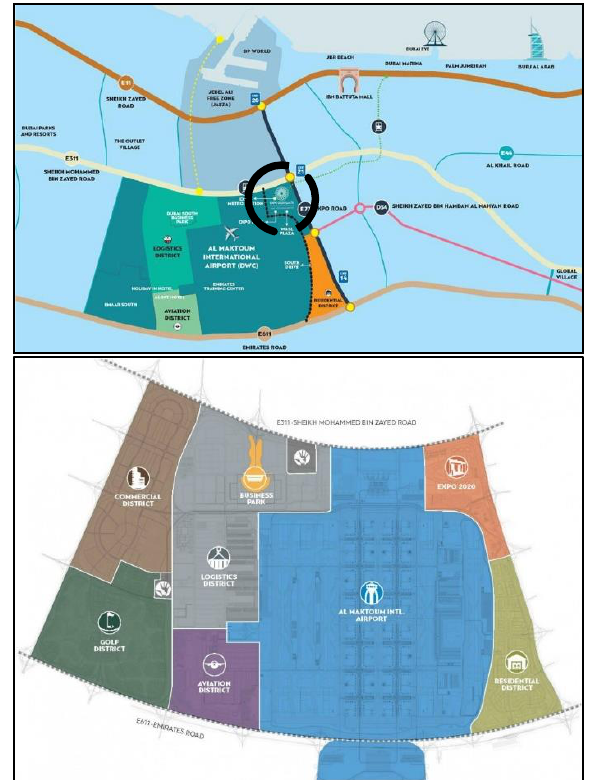
Figure 2 . The location of Dubai Expo 2020 Site within Dubai South (Dubai South,